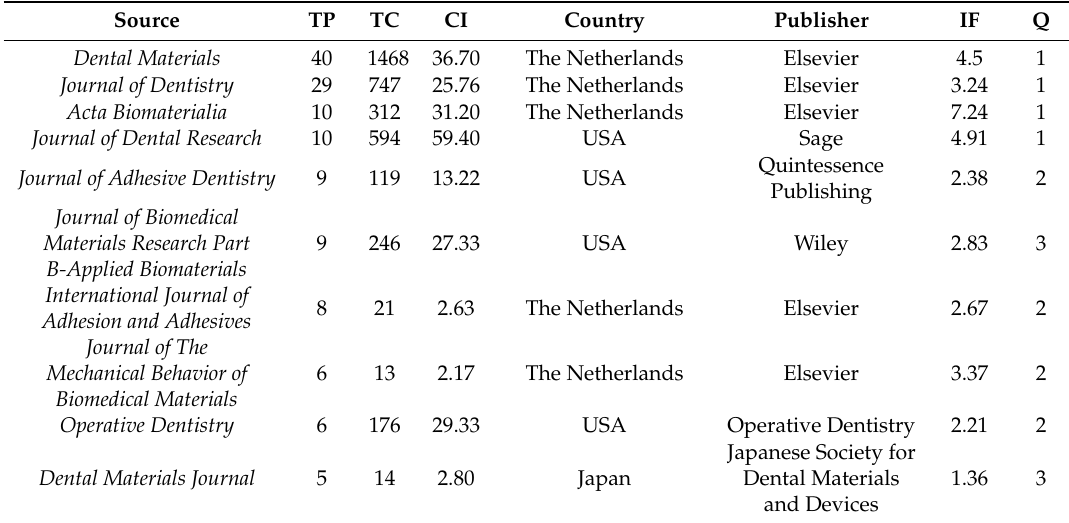
Table 2. Highly influential journals in relation to published articles on antibacterial dental adhesives Source TP TC